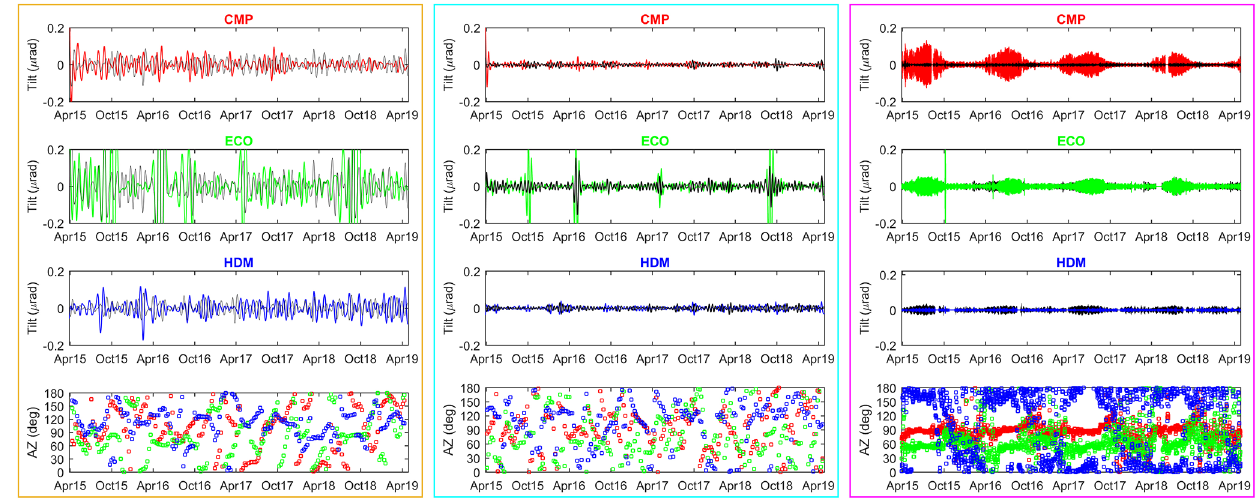
Figure 2. Time series of the two tiltmeter components (EW in red, green and blue for CMP, ECO and HDM, respectively; NS always in black for the three instruments) and temporal pattern of the azimuth. From left to right, the three boxes in ocra, cyan and magenta are relative to the results obtained in the period band corresponding to the Mm, Mf and S1 tidal constituents, respectively.